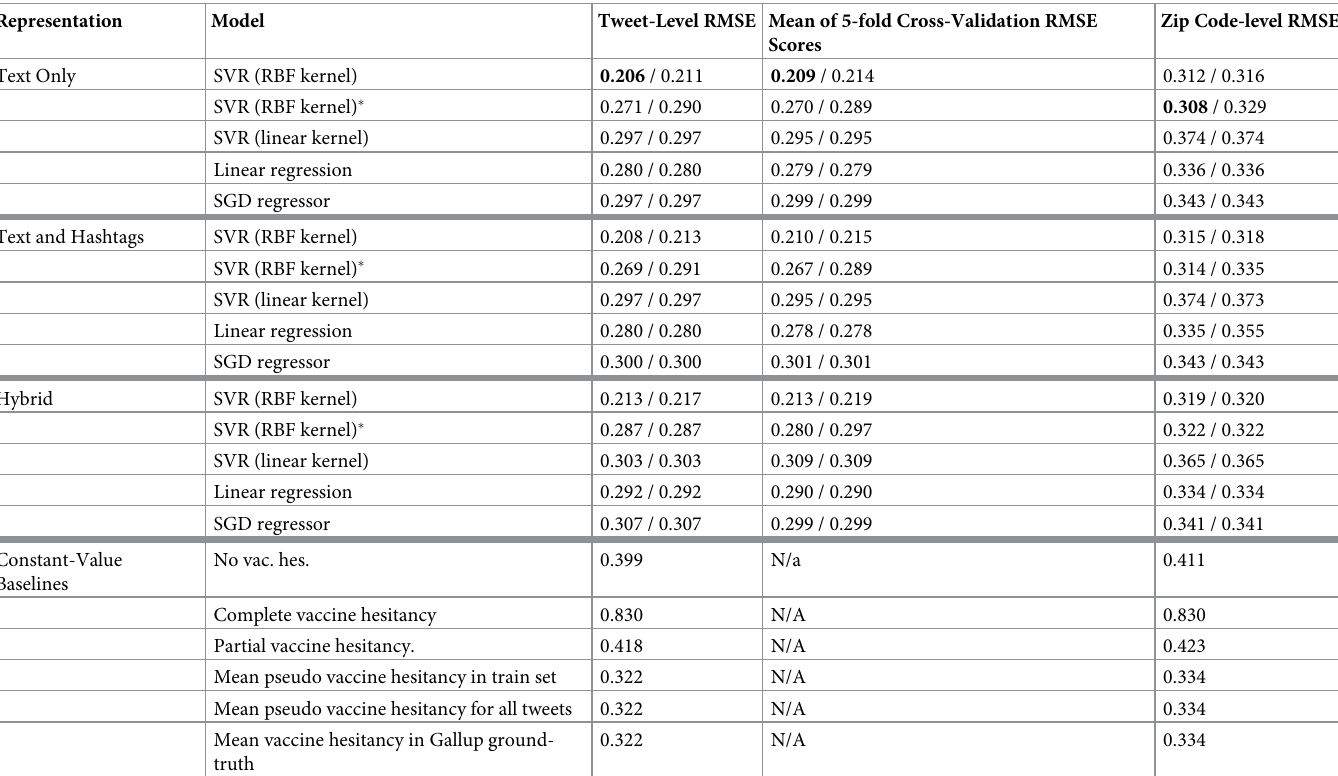
Table 4. The Root Mean Square Error (RMSE) scores at both the tweet-level and zip code-level for all models, along with the average of the 5-fold cross-validated RMSE scores for the predictive models. Models specified with ( � ) do not include any zip code-level features. The other models include all zip code-level features, in addi- tion to text. The RMSE scores for the predictive models, with and without sentiment as a feature, are reported as without sentiment / with sentiment . Cross-validation is not applicable for baseline models.